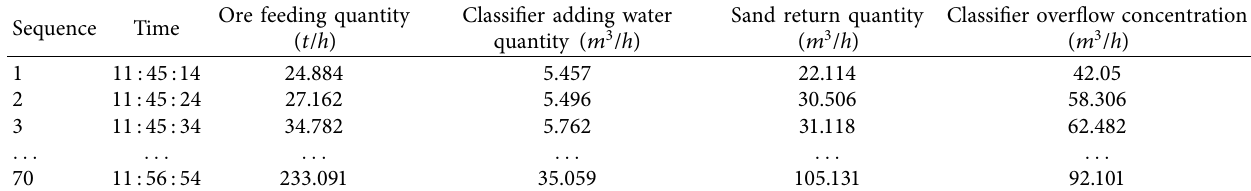
Table 5: Sampling data [27].